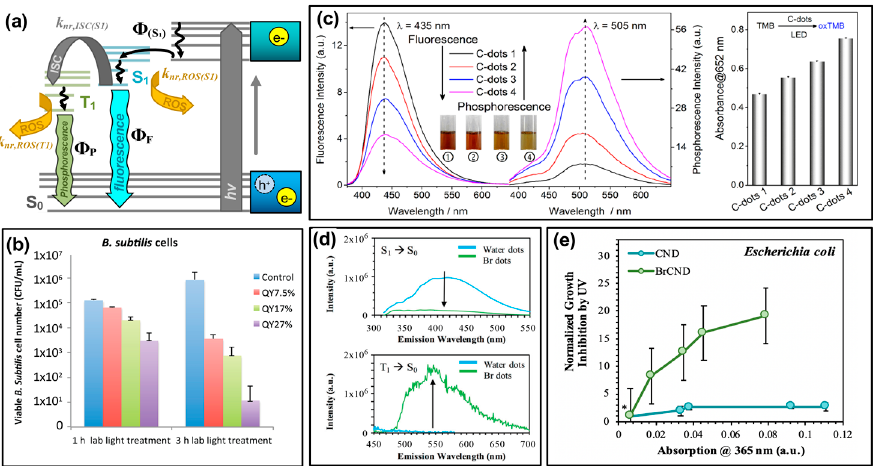
Figure 6. Tuning the quantum yield ( Φ ) values of carbon nanodots for optimized antimicrobial activity. ( a ) Modified Jablonski diagram showing initial absorption by carbon nanodots and subsequent transition to an emissive excited state ( Φ S1 ), whereby the state may radiatively relax ( Φ F ) or undergo non-radiative transitions including intersystem crossing (“ISC”, k nr,ISC(S1) ) to an excited triplet state (T 1 ) or generation of reactive oxygen species (ROS). ( b ) Viability of Bacillus subtilis after treatment with light-activated carbon nanodots of varying fluorescent quantum yield, “QY”. ( c ) Left —Fluorescence and phosphorescence emission spectra for comparable carbon nanodot structures displaying variable quantum yield values (C-dots 1–4). Right —Detection of reactive oxygen species by TMB (3,3 ′ ,5,5 ′ -tetramethylbenzidine) absorption increases, correlating to the phosphorescence quantum yield of varying carbon dot species. ( d ) Top —Fluorescence decrease from carbon dot samples (CND / “water dots”) following bromination (BrCND / “Br dots”) and bottom —corresponding changes in phosphorescence for the same samples. ( e ) Growth inhibition of Escherichia coli for phosphorescent carbon dots (BrCND) versus fluorescent carbon dots (CND) of varying concentrations (reported by corresponding absorption values); values were normalized to those for a non-BrCND-containing solution (*), from Reference [56]. For additional details regarding the reported studies, the reader is referred to Table 1 of the main text. Abbreviations: k nr,ISC(S1) (rate of ISC from S 1 excited state), k nr,ROS(T1) (rate of ROS generation from triplet states), k nr,ROS(S1) (rate of ROS generation from singlet states), oxTMB (oxidized TMB). Permissions : ( b ) Adapted from Reference [24]—Published by The Royal Society of Chemistry. ( c ) Adapted with permission from Reference [55]. Copyright © 2018, American Chemical Society. ( d ) Adapted from Reference [46]—Published by the PCCP Owner